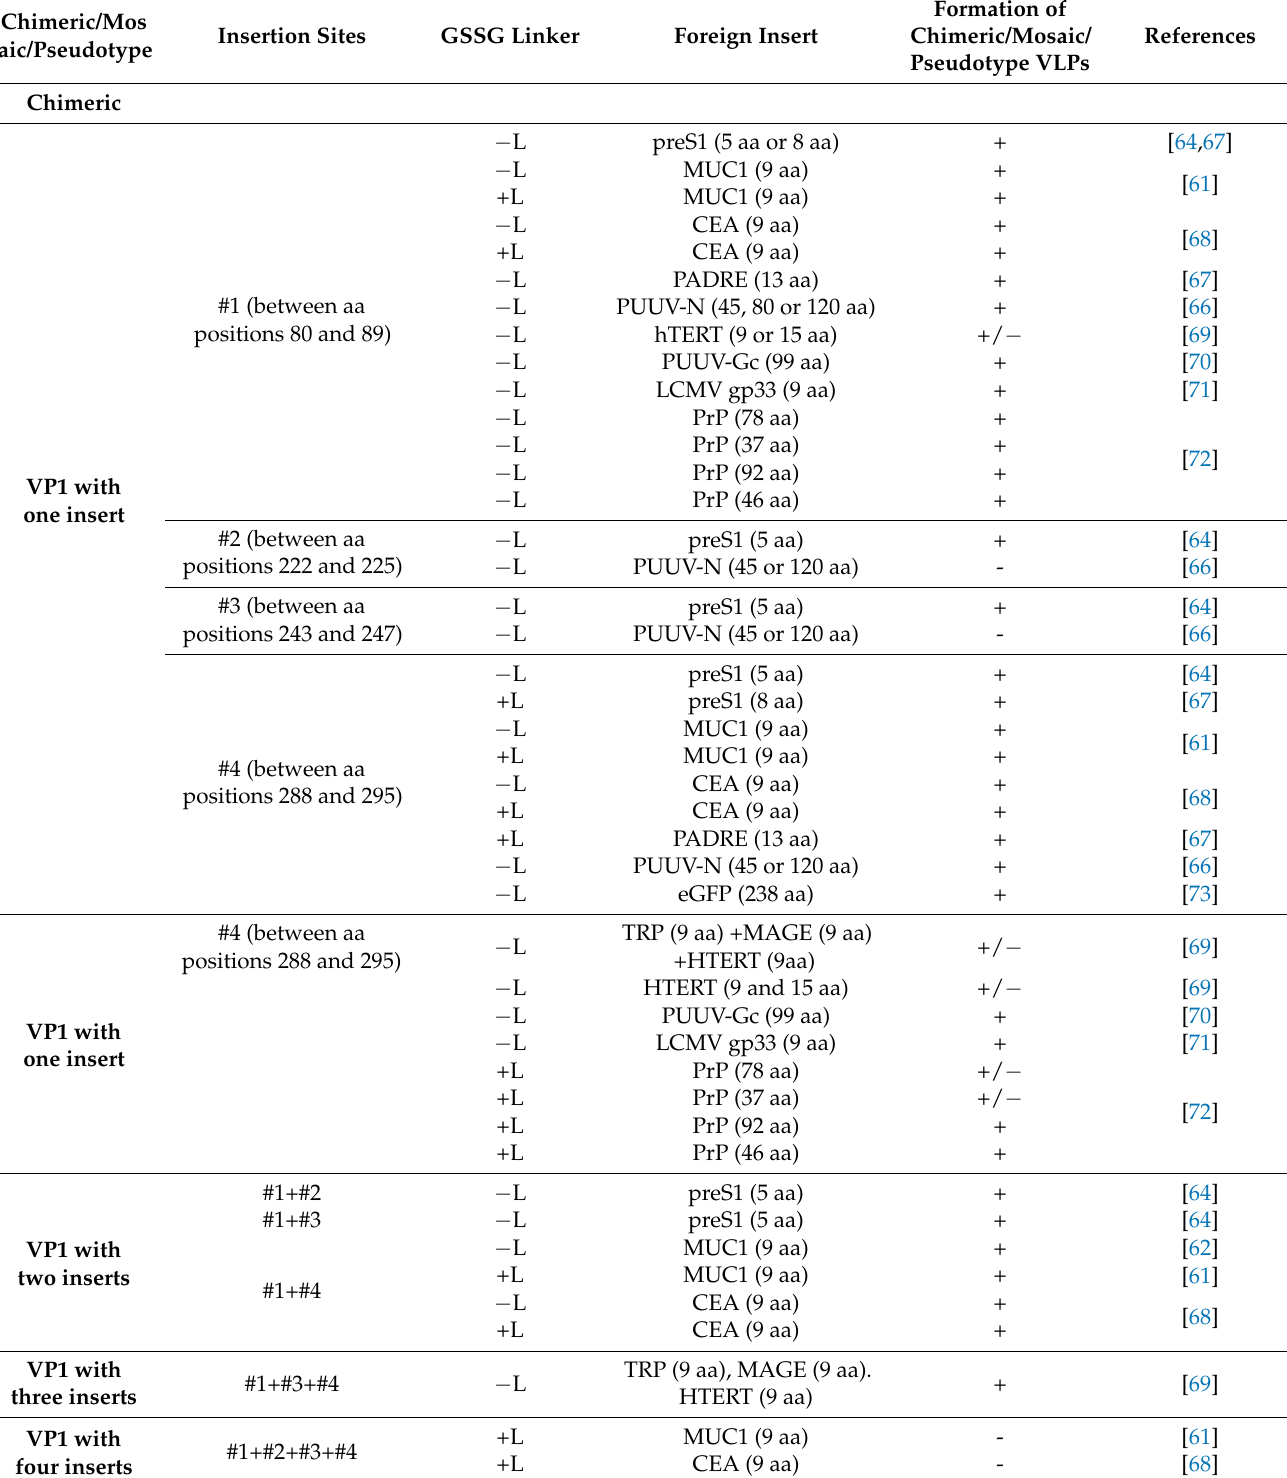
Table 2. Overview about hamster polyomavirus-derived chimeric, mosaic and pseudotype virus-like particles.